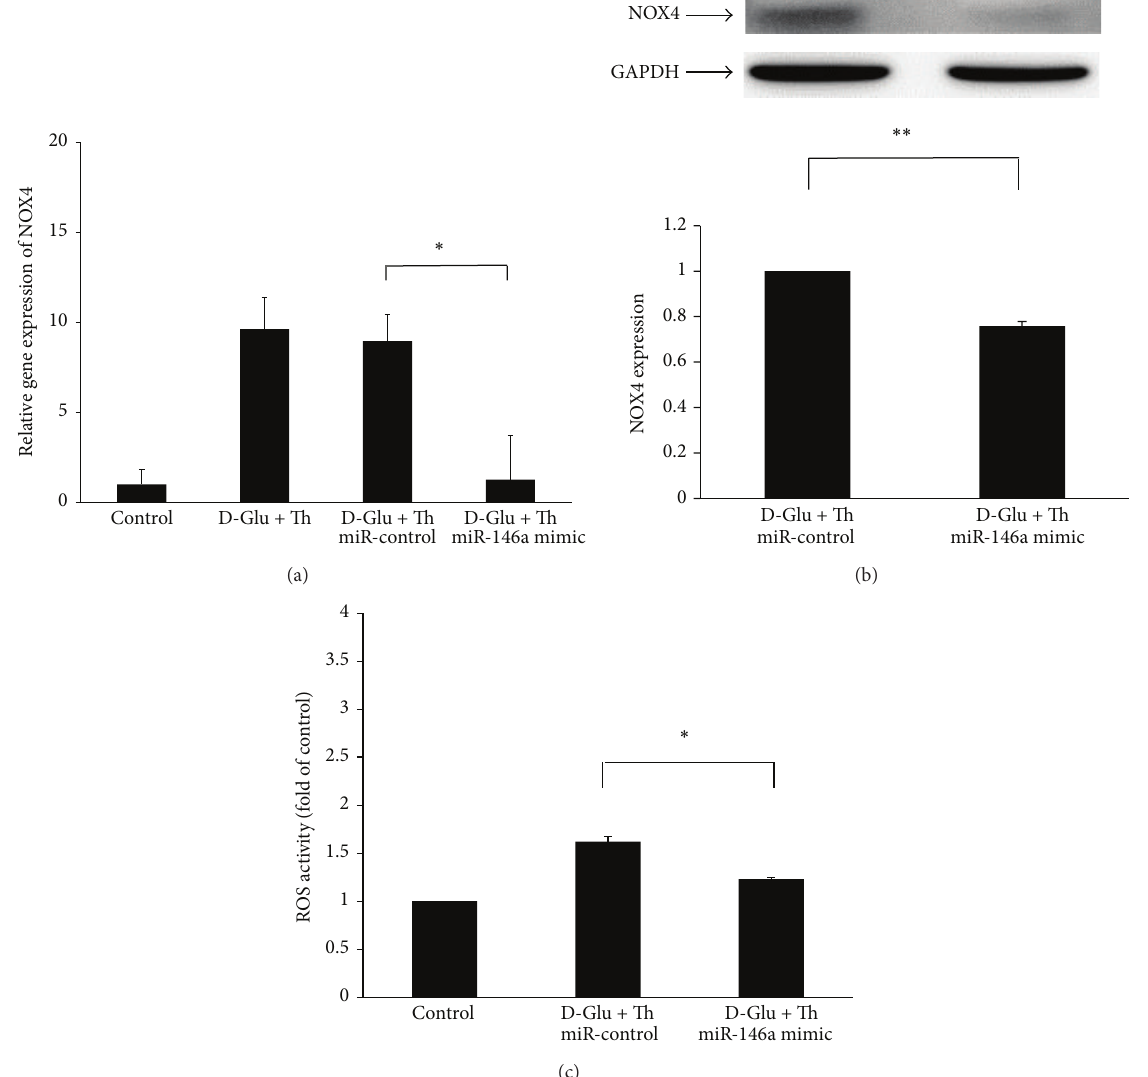
Figure 5: The stimulatory effects of HG/thrombin on Nox4 expression and ROS production were attenuated in miR-146a mimic-transfected HAECs. (a) The stimulatory effect of HG/thrombin on Nox4 mRNA expression was preserved in miR-control-transfected HAECs, with an increase of 8.95-fold Nox4 mRNA levels compared with the control. In contrast, HG/thrombin did not increase Nox4 mRNA expression in miR-146a mimic-transfected HAECs. The bars represent the means ± SEM from 3 experiments. ∗ 𝑃 < 0.05 , as compared with the miR- control. (b) The stimulatory effect of HG/thrombin on Nox4 protein expression was significantly attenuated in miR-146a mimic-transfected HAECs. The bars represent the means ± SEM from 4 experiments. ∗∗ 𝑃 < 0.01 , as compared with the miR-control. (c) The stimulatory effect of HG/thrombin on intracellular ROS production was significantly attenuated in miR-146a mimic-transfected, HG/thrombin-stimulated HAECs. The bars represent the means ± SEM from 3 experiments. ∗ 𝑃 < 0.05 , as compared with the